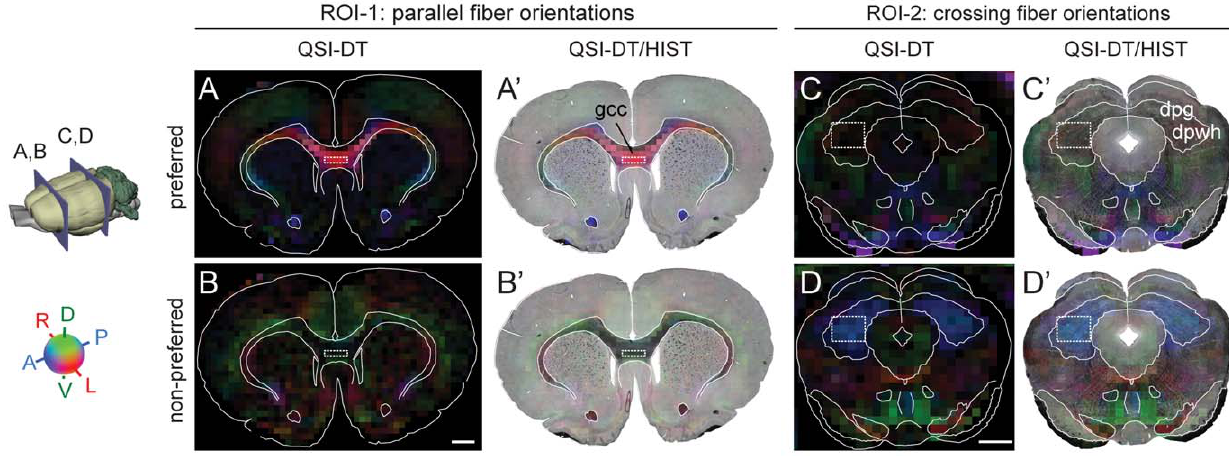
Figure 1. Selection of regions-of-interest. Anatomical ROIs containing coherent or crossing fiber orientations without anterior-to-posteriorly orientated fibers were identified using red-green-blue (RGB) maps of the preferred ( A,A 9 , C , C 9 ) and non-preferred ( B,B 9 , D,D 9 ) diffusion direction, indicated by the first and third eigenvector of the DT, respectively. Voxel colors indicate the direction of the respective eigenvectors (cf. color code insert, bottom left), while the voxel brightness is given by the degree of linear and planar diffusion anisotropy for the preferred and non-preferred maps, respectively. ( A , B ) Coronal RGB maps through the genu of the corpus callosum, and ( C , D ) coronal RGB maps through the brain stem at level of the superior colliculus (position indicated on the 3D rat brain insert). ( A 9 – D 9 ) Overlay of RGB maps and corresponding myelin stained section images. The bright red color in ( A , A 9 ) indicates a high degree of linear anisotropy with left-right orientation, consistent with coherent mediolaterally oriented commissural fibers in this region (see, also Fig. 2C). In the corresponding non-preferred map ( B , B 9 ), the same voxels are dark, indicating a lack of planar diffusion anisotropy. The bright blue color of the non-preferred map in ( D , D 9 ) indicates a high degree of planar anisotropy (typical of crossing fibers, see, also Fig. 2D) within the coronal plane. In the corresponding preferred map ( C , C 9 ) these voxels are dark, consistent with a lack of uniformly oriented fibers. For our quantitative analysis, we selected four voxels in a 1 6 4 grid in the bright red region in the corpus callosum (ROI-1; dotted white frame in A , A 9 , B , B 9 ) and twelve voxels in a 3 6 4 grid in the bright blue region in the tectum (ROI-2; dotted white frame in C , C 9 , D , D 9 ). dpg, deep gray layer of the superior colliculus; dpwh, deep white layer of the superior colliculus; gcc, genu of the corpus callosum. Scale bars, 1 mm.